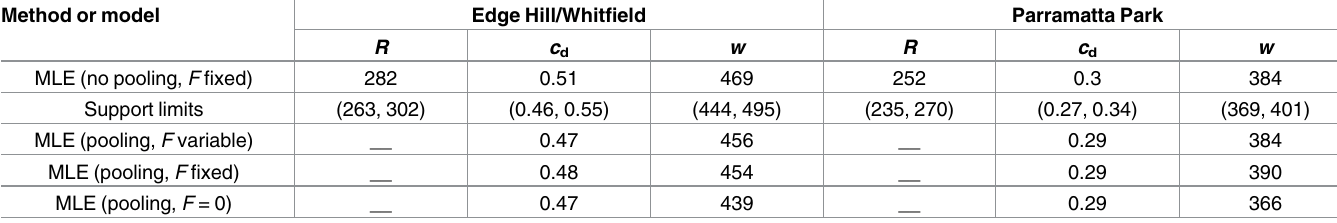
Table 1. Maximum likelihood estimates(MLEs) of parameters describing spatial